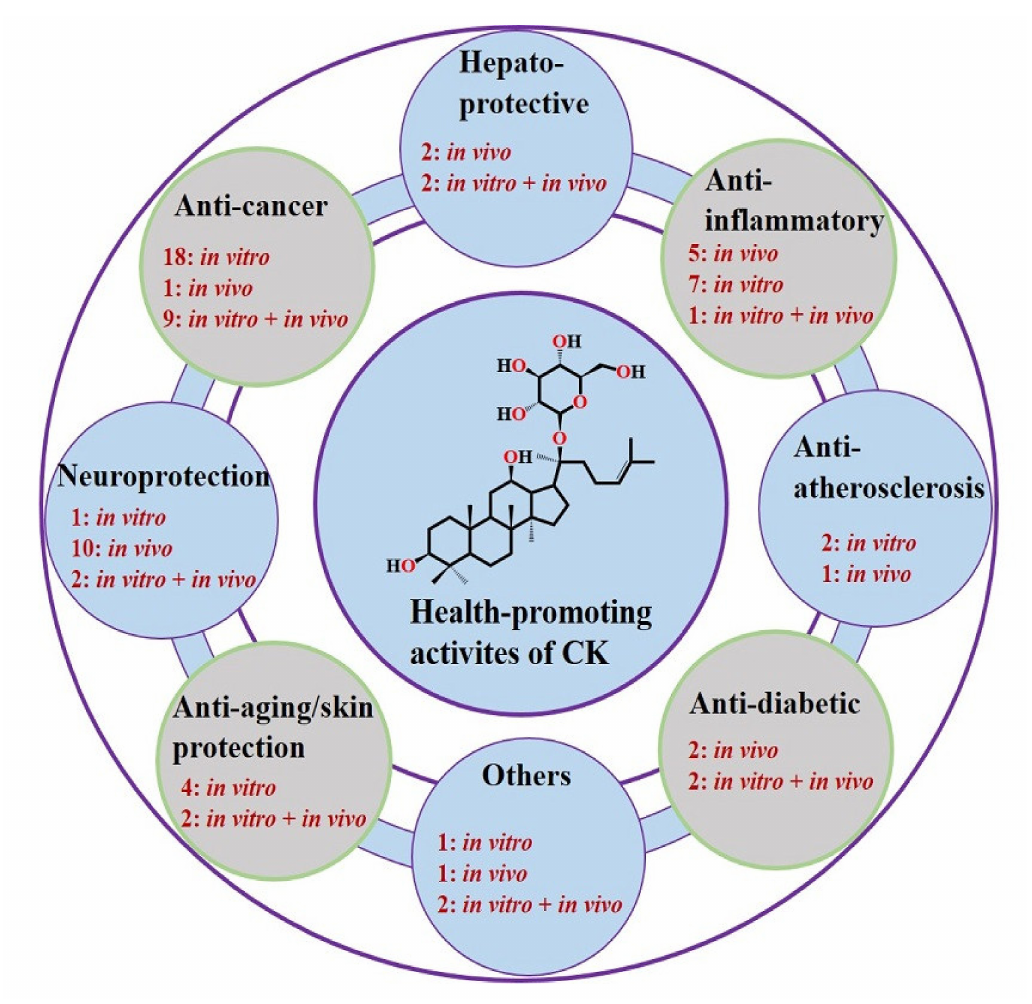
Figure 2. Schematic illustration of health-promoting activities of Compound K (CK). The numbers in the figure represent the total number of studies assessed for evaluating in vitro and in vivo, health-promoting activities of